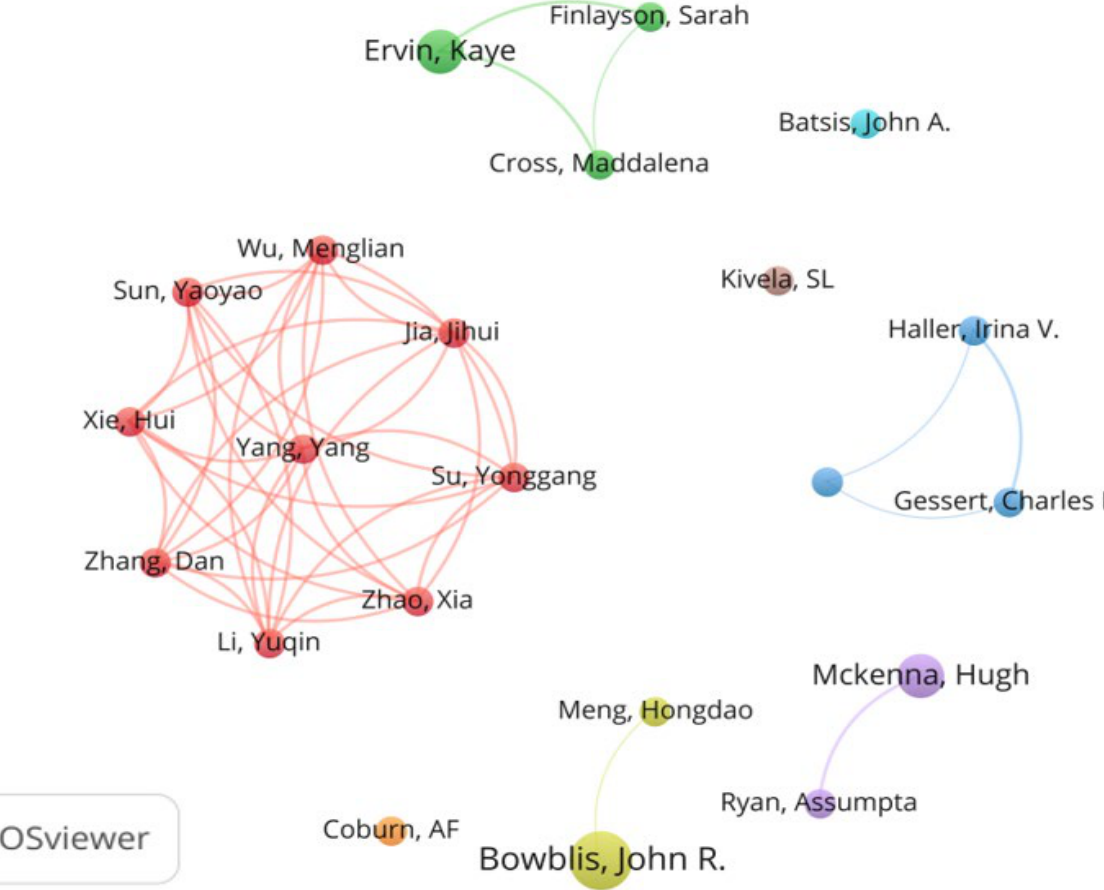
Figure 5. Map of co-authorship in the field of rural institutional elder care. Reference: [21–43]. Note: The reference citation number herein is the reference citation number in the text. Table 2. Quantitative measurements of scholars in rural institutional elder care research.